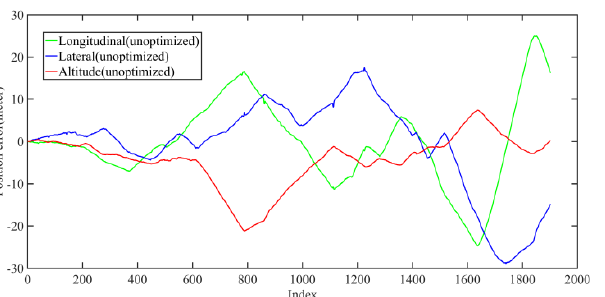
Figure 5. The unoptimized position error in longitudinal, lateral, and altitude directions of KITTI dataset, respectively.